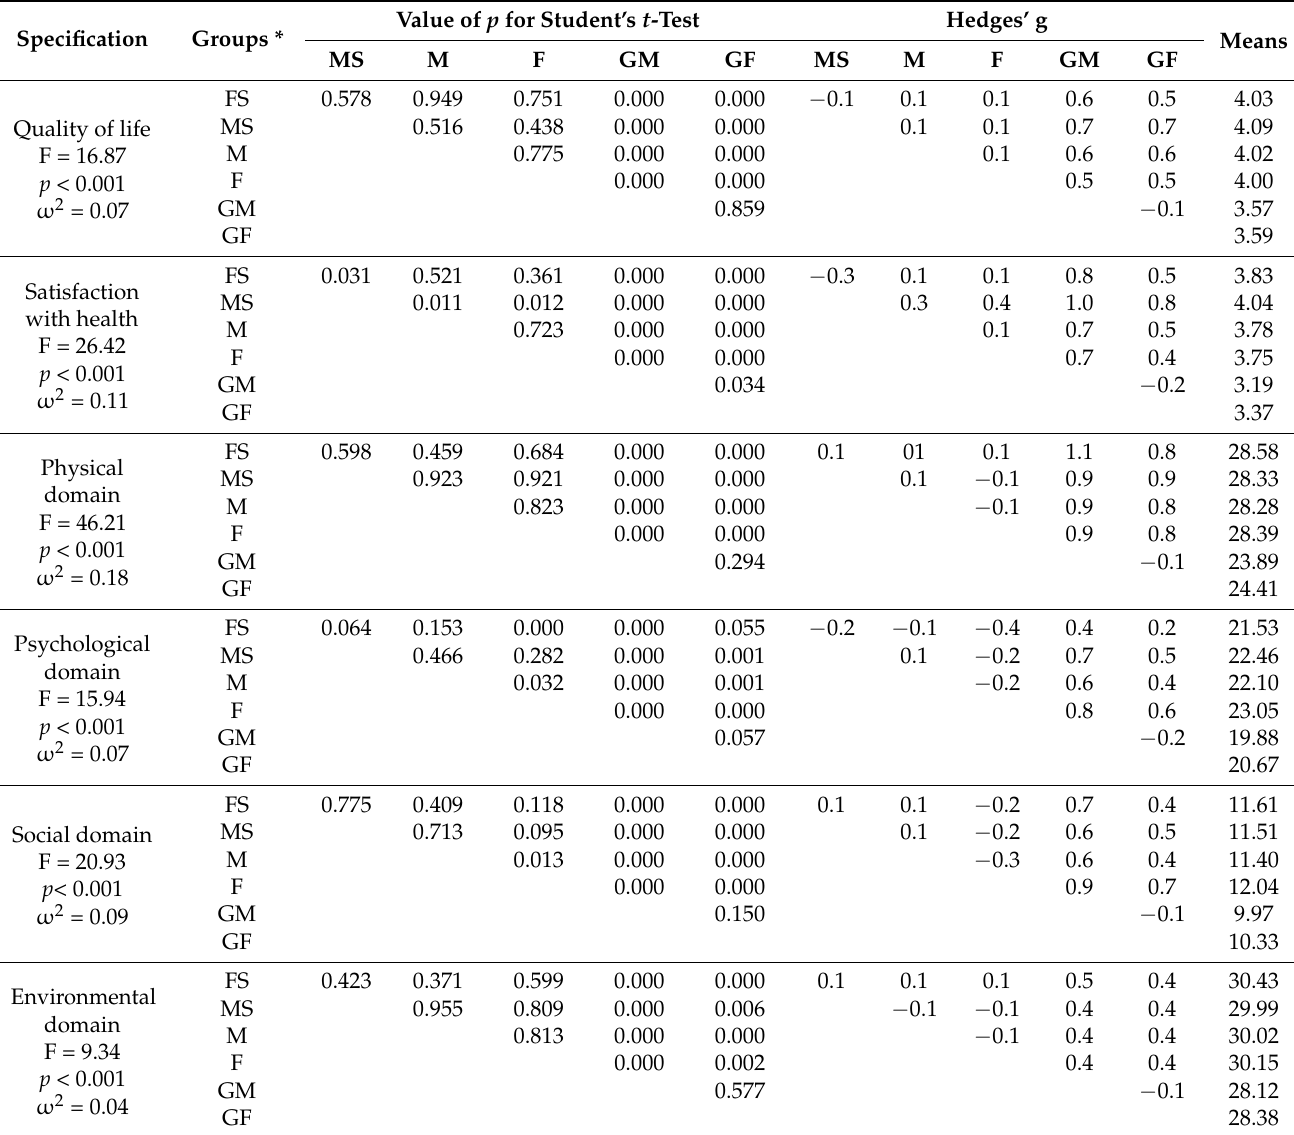
Table 1. Total quality of life in individual domains (physical, psychological, social, environmental) and satisfaction with health among university students, their parents, and their grandparents (F-test, ω 2 , Student’s t -test, Hedges’